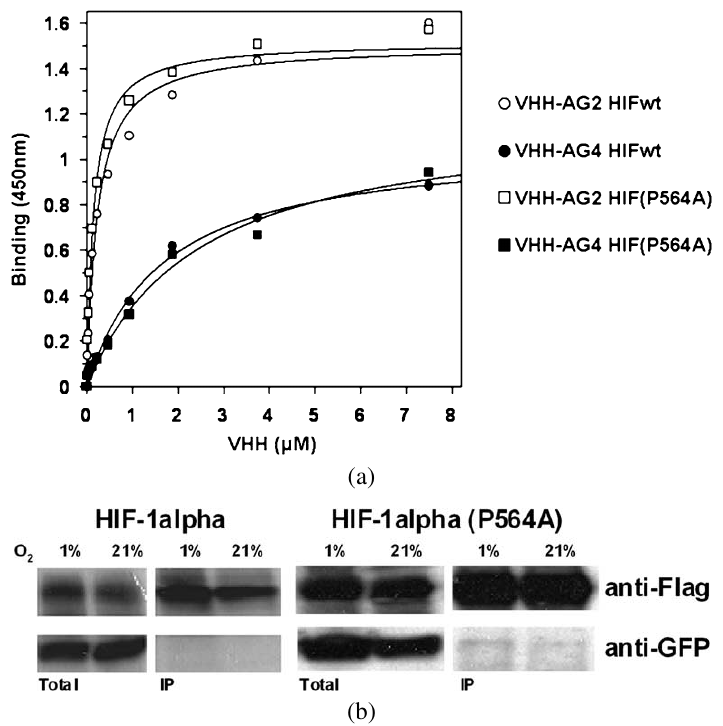
Fig. 3. P564 is not necessary for binding of VHH-AG2 to HIF-1 α . (a) ELISA VHH binding assay to wild type and mutant recombinant HIF-1 α . VHH-AG2 (binds to aa543-605), and as an internal control VHH-AG4 binds to (aa375-455), were incubated with immobilized recombinant wild type and mutant P564A HIF-1 α fragment B (aa375-605). Binding is expressed as OD at 450 nm and expressed as mean of duplicate experiments. (b) Immunoprecipitation of FLAG-HIF-1 α and mutant FLAG-HIF-1 α –P564A with bivalent VHH-AG2 (AG-1N2C-MYC) from U2OS transfected cells with H2B-GFP as a control. Cells were exposed to normoxic (21%) or hypoxic conditions (1% O 2 ) for 24 h after transfection. Total lysates and IPs were submitted to immunoblot analyses with anti FLAG and GFP